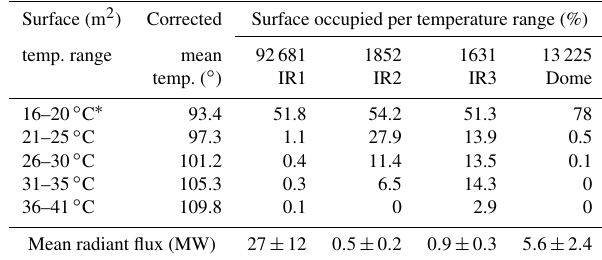
Table 2. Major and trace composition of Awu lava dome. Table 3. Thermal radiant flux from Awu crater.